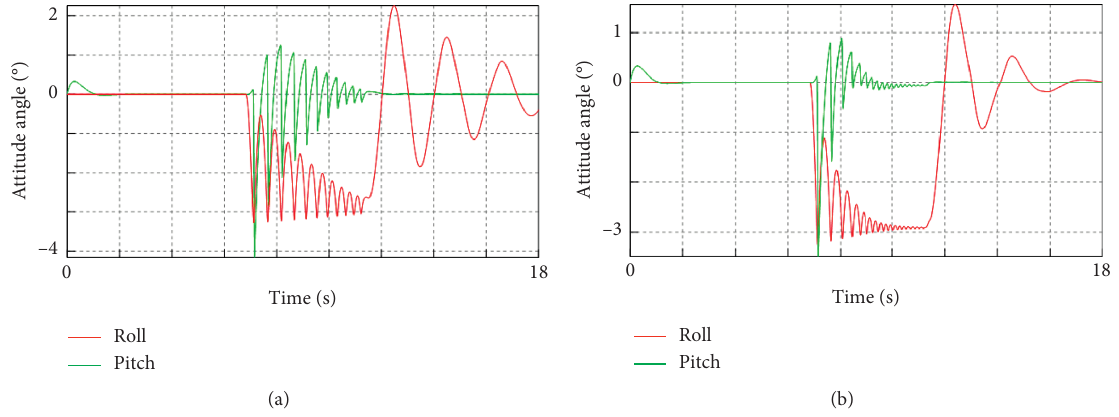
Figure 22: Changes of the attitude angle under different supporting wheel treads: (a) 322mm and (b)